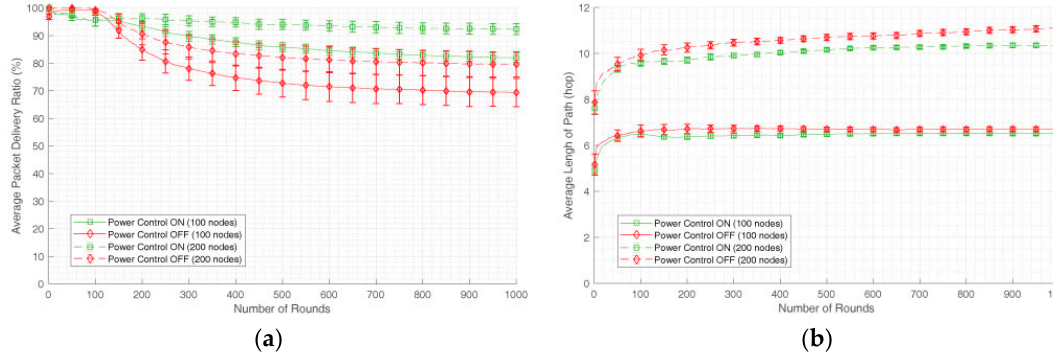
Figure 7. Network performance in a clustered network in terms of ( a ) average packet delivery ratio and ( b ) average length of path.